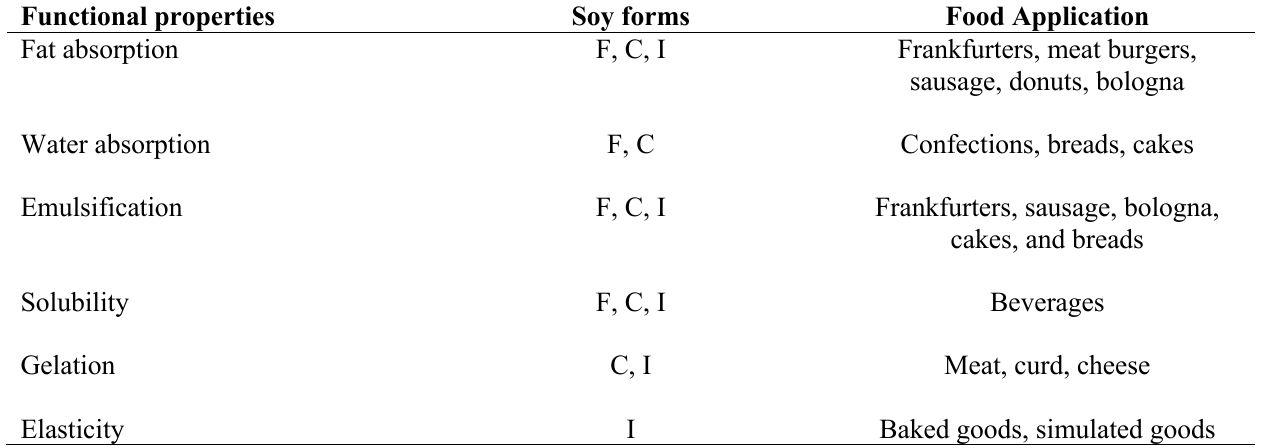
Table 1. Application of soy protein in food products Functional